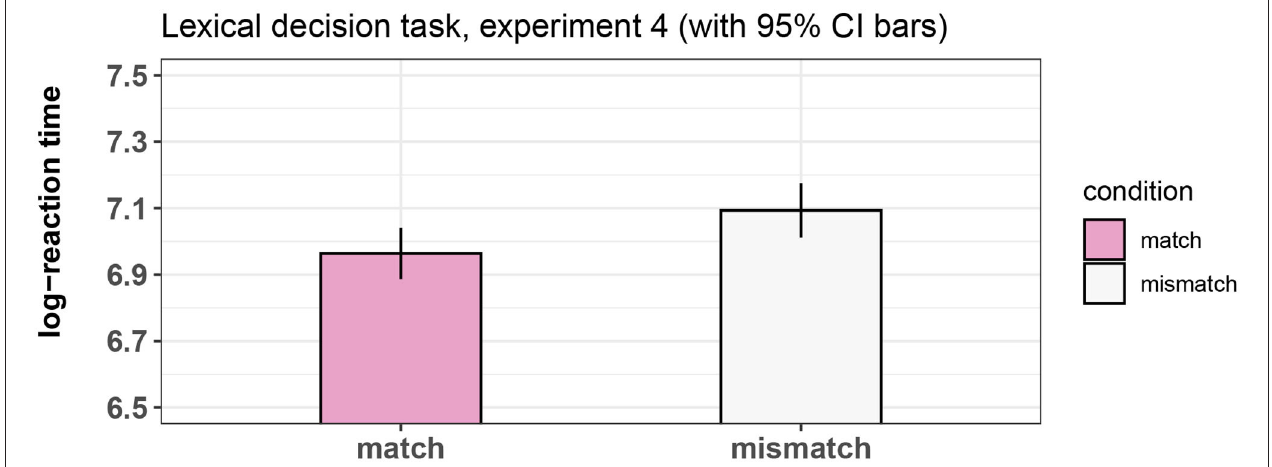
FIGURE 12 | Summary of results for the lexical decision task, Experiment 4.